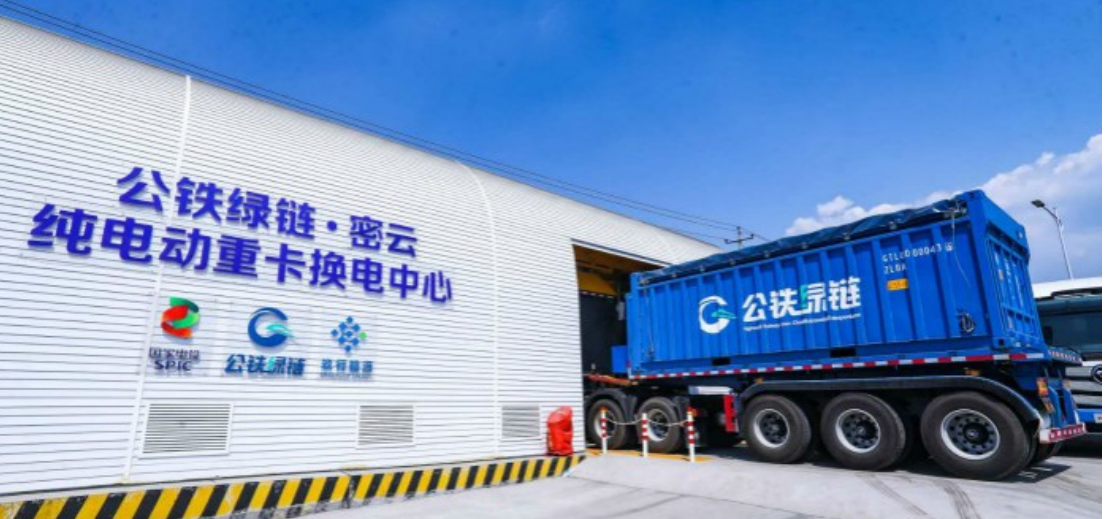
Figure 2. Battery-swapping station of BS-HDT and battery-swapping process in the “Beijing Case”.